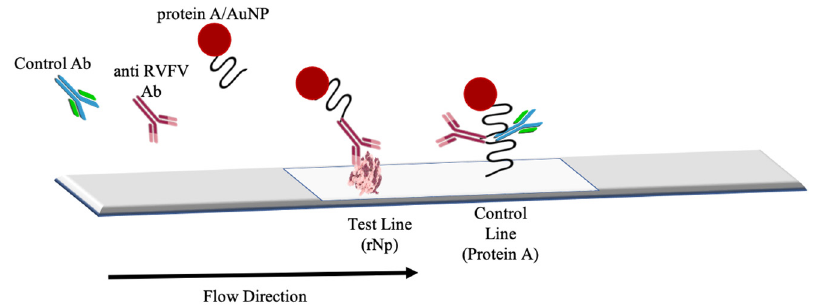
Figure 2. An illustration of RVFV lateral flow strip for a positive test.